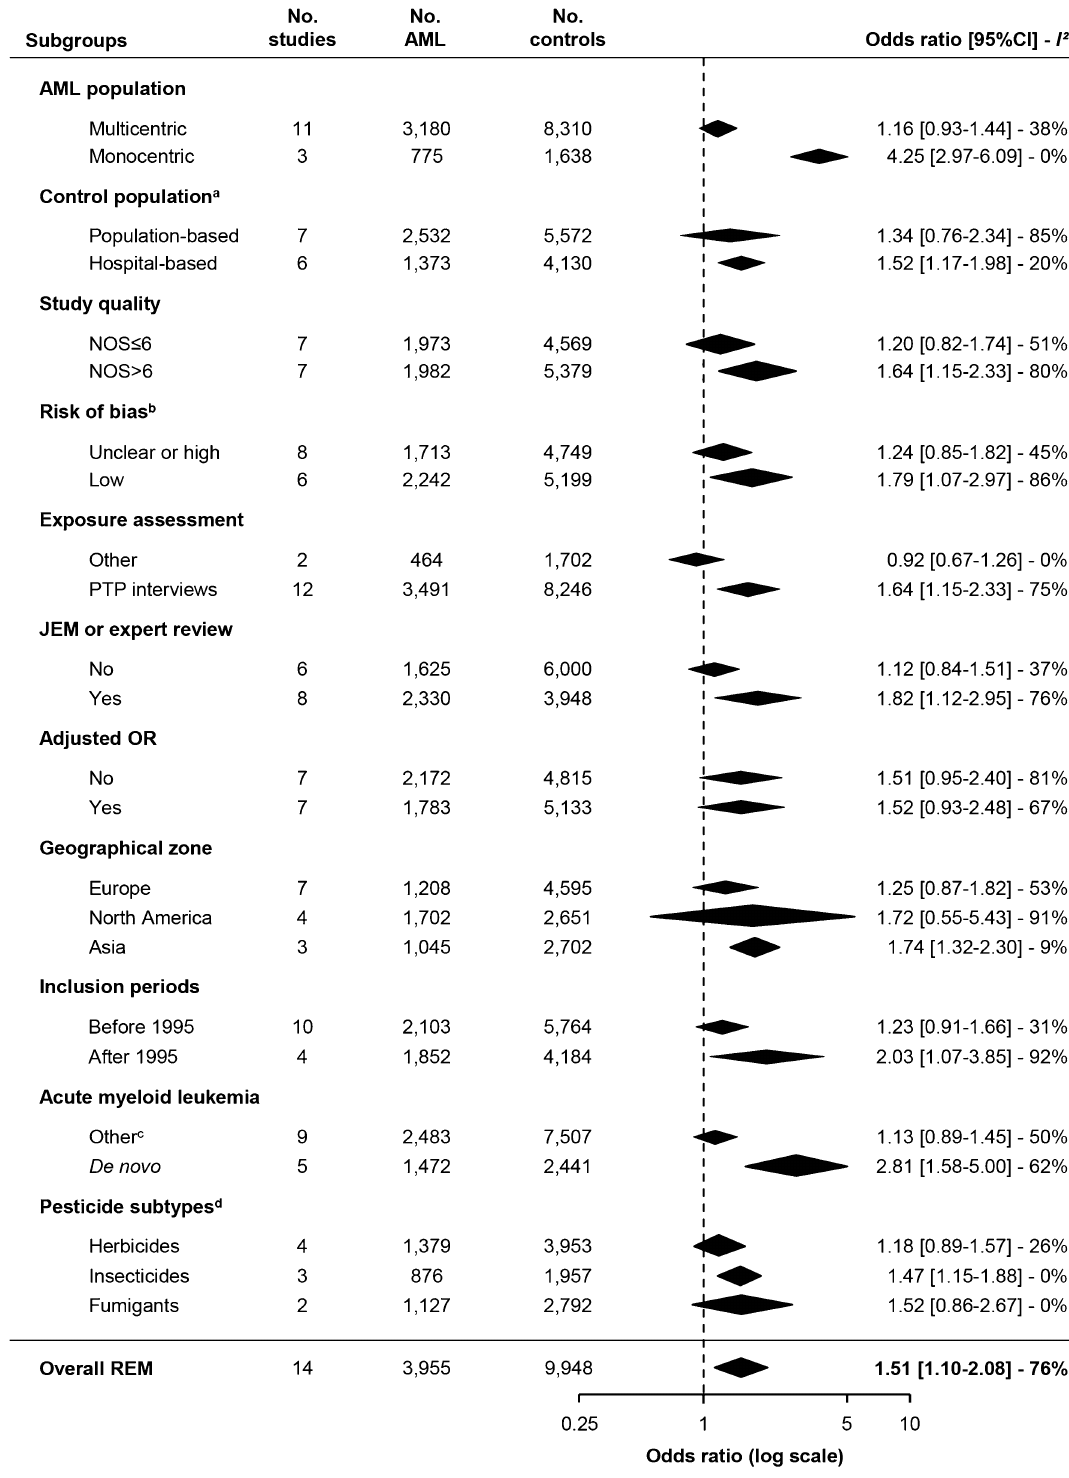
Figure 6. Forest plot illustrating the risk estimates and their 95% confidence intervals (95%CI) within subgroups of included studies. Subgroups are presented in ascending order according to their mean effects. The center and width of diamonds represent mean OR and 95%CI. Heterogeneity within each stratus is reported with I 2 . a Cicconne et al. 36 not included: hospital- and population-based; b risk of bias classification was performed using correspondence analysis described in Fig S3; c other: de novo status was not mentioned or 0.69% of secondary acute myeloid leukemia (sAML) in Wong et al. 43 ; d only studies reporting specific pesticide exposure were included for this subset analysis. NOS: Newcastle–Ottawa scale; PTP: peer-to-peer interviews. Description of articles and number of subjects included in each stratus are shown in Table S8. This figure was performed using R software 30 with the “metafor” package 28